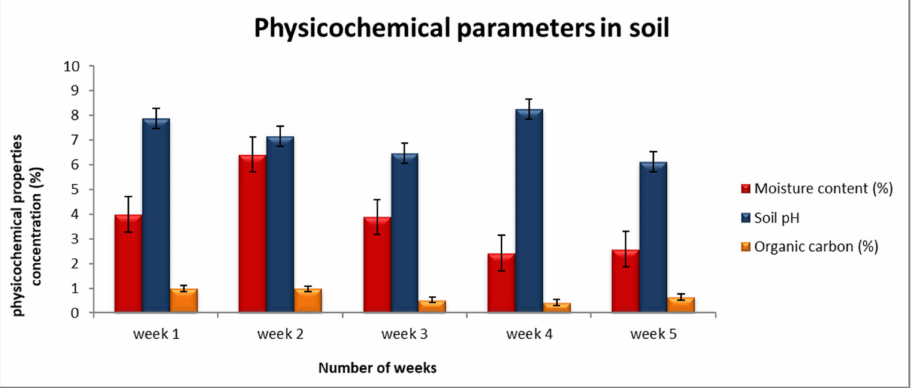
Figure 1. The soil physicochemical properties result for the five weeks sampling